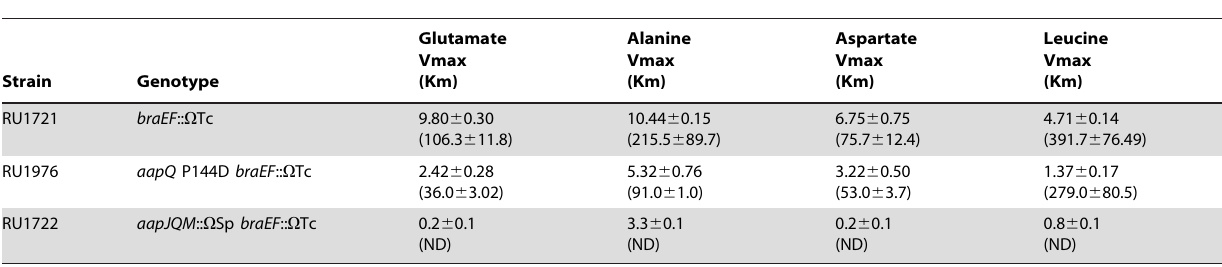
Table 1. Transport of amino acids by strains of R. leguminosarum bv. viciae.